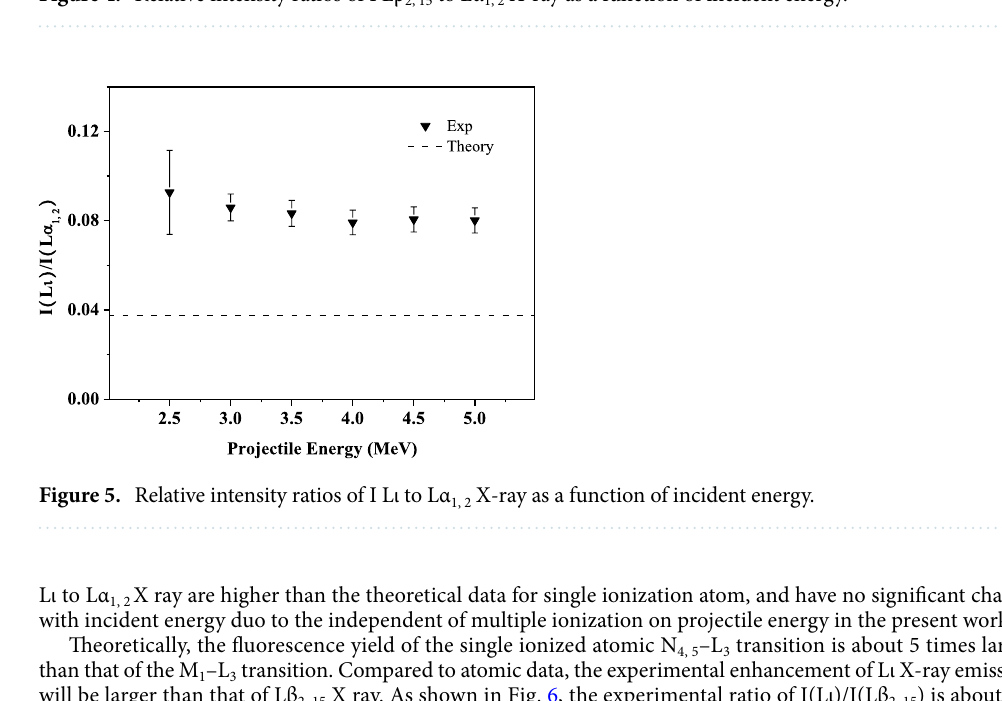
Figure 4. Relative intensity ratios of I Lβ 2, 15 to Lα 1, 2 X-ray as a function of incident energy.